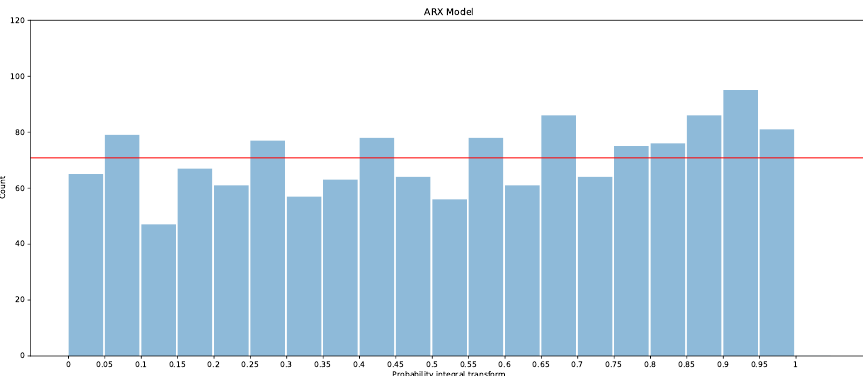
Figure 20. PIT for the ARX model for the first two months of the test set.